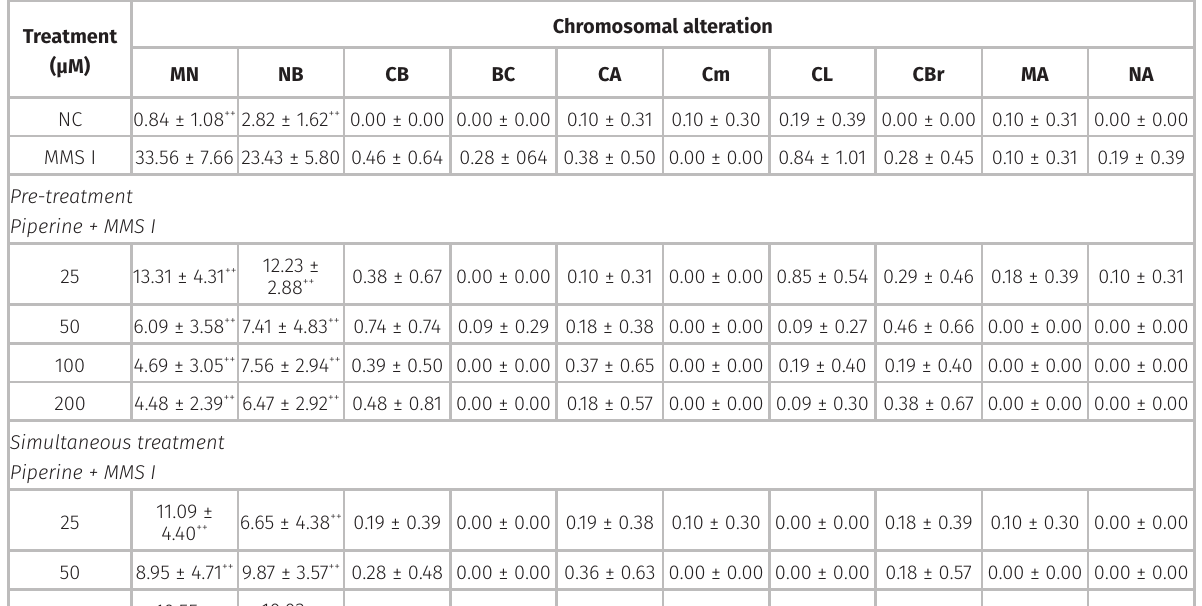
Table IV. Chromosomal alterations in meristematic cells of A. cepa exposed to different concentrations of piperine or